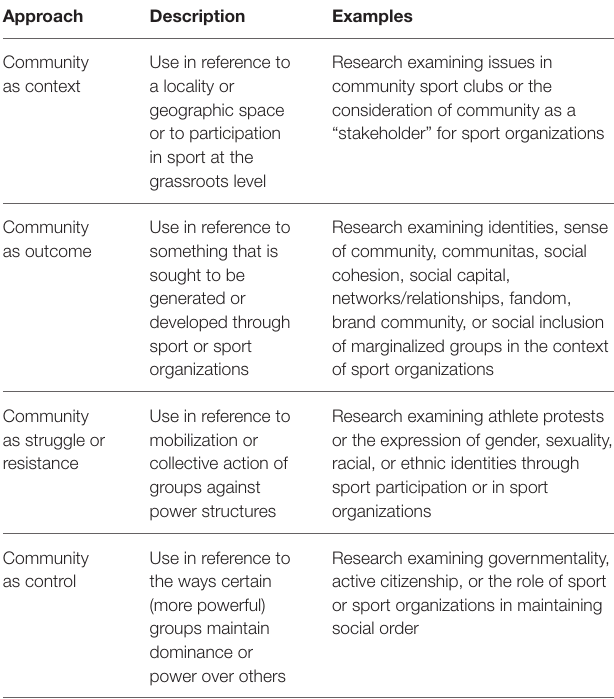
TABLE 1 | Approaches to community in sport